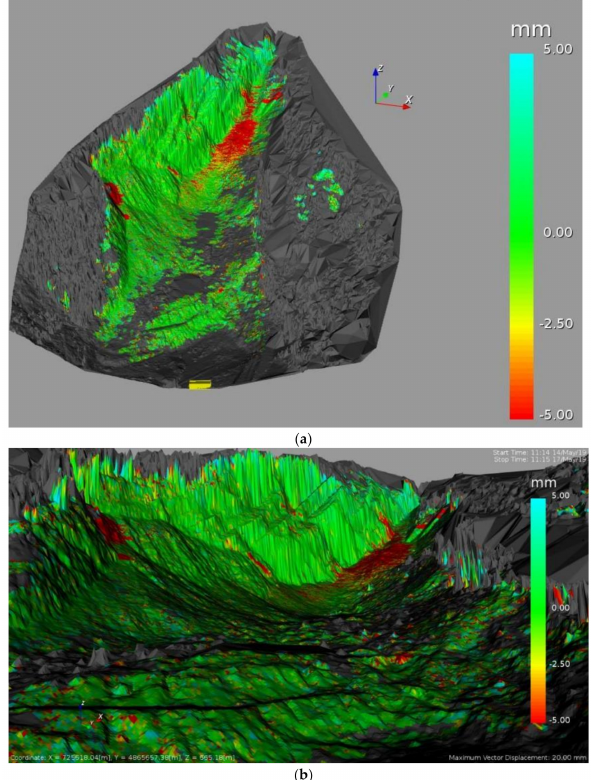
Figure 10. Line Of Sight (LOS) displacement map as result of 72 h monitoring of the Poggio Baldi landslide by HYDRA-G ArcSAR: ( a ) Landslide top view with the cumulative LOS displacement map overlaid on the 3D model of the slope; ( b ) The same LOS displacement map from the viewpoint of HYDRA-G.